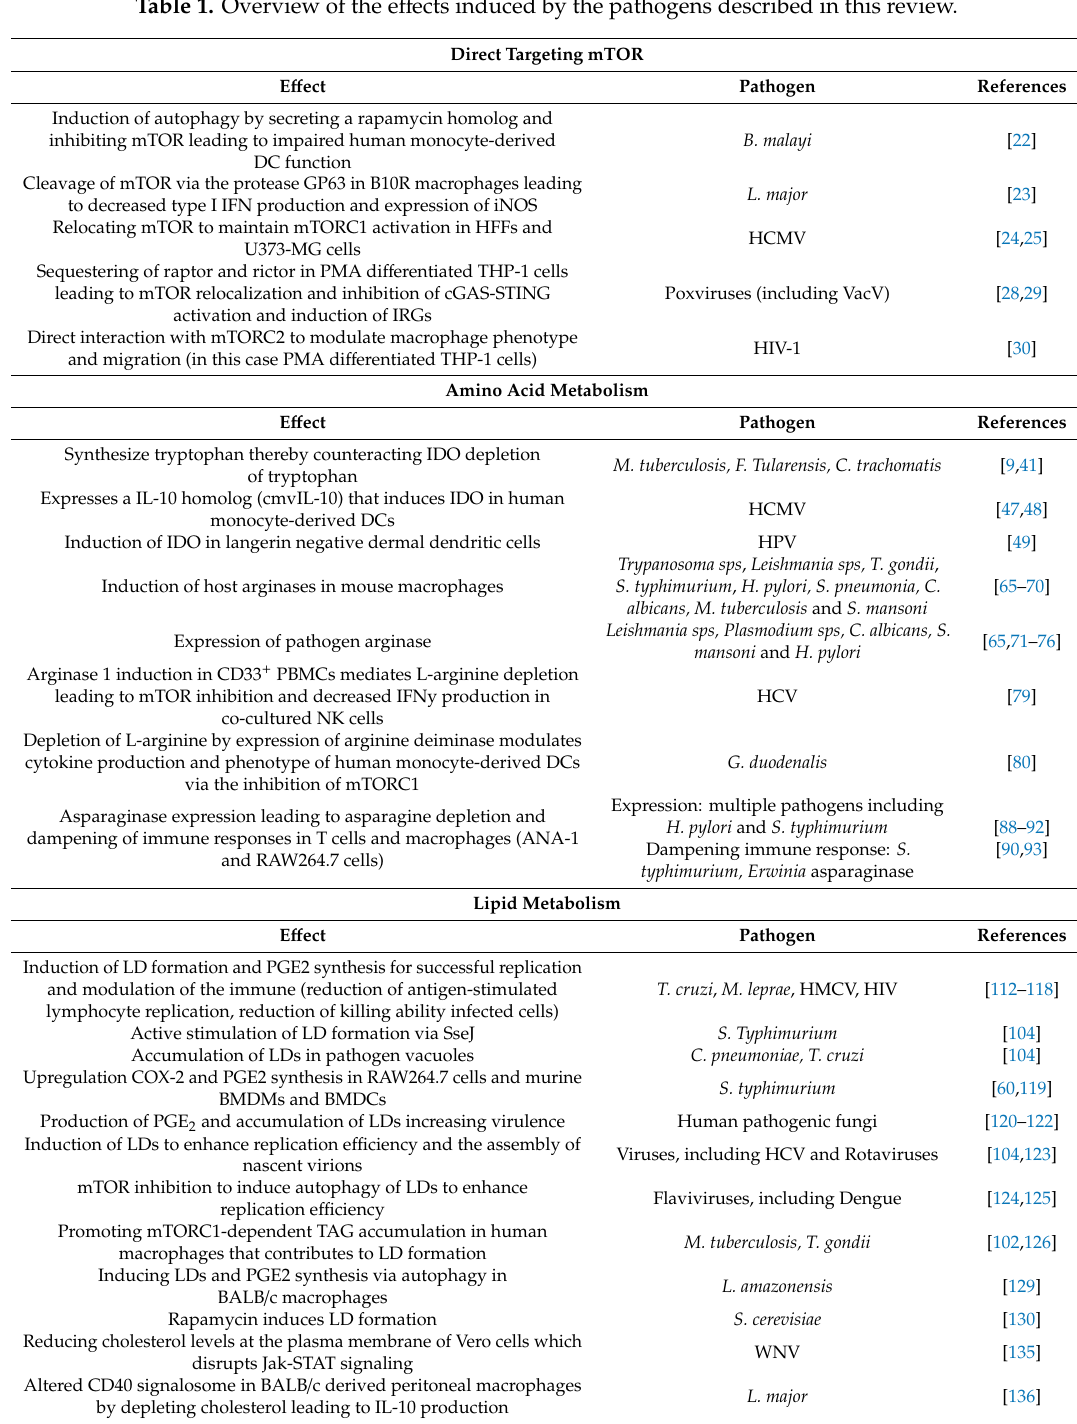
Table 1. Overview of the e ff ects induced by the pathogens described in this